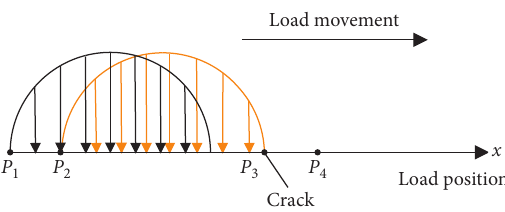
Figure 12: Relative position of crack and load.